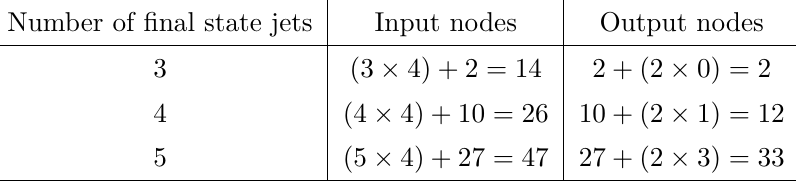
Table 1 . List of the number of input and output nodes for every process we